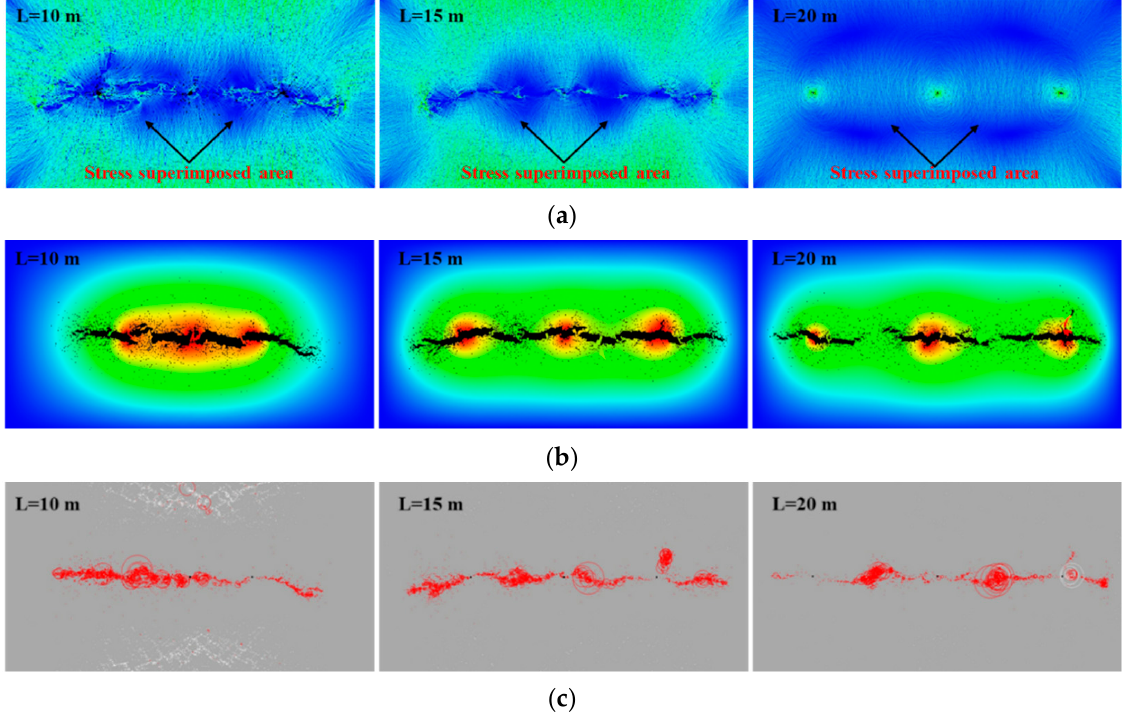
Figure 13. Comparison of hydraulic fracturing effects with different hole spacings. ( a ) Shearing stress distribution due to hydraulic fracturing. ( b ) Pore water pressure distribution due to hydraulic fracturing. ( c ) Acoustic emission distribution due to hydraulic fracturing.